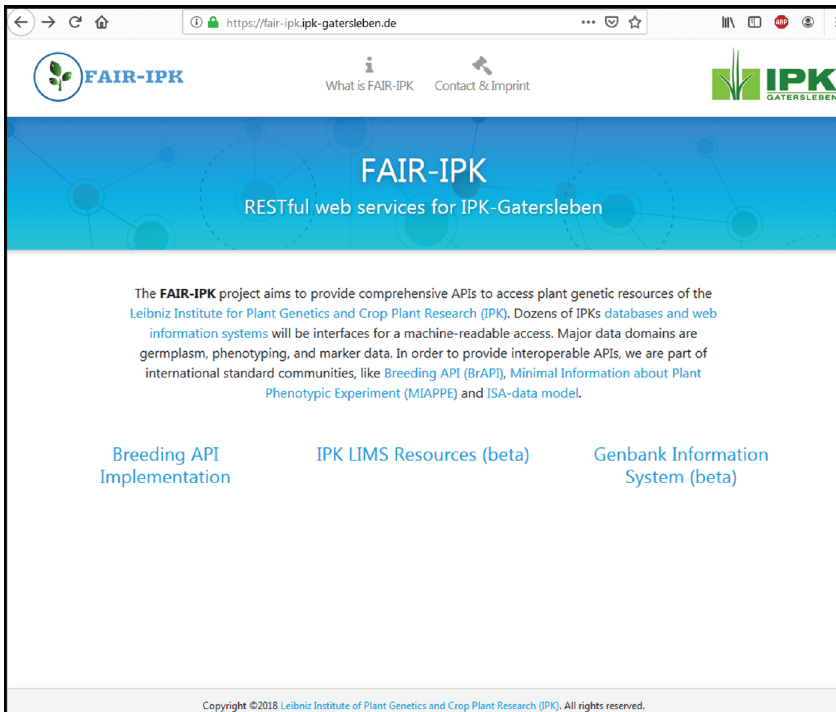
Figure 3: Web interface for accessing digital PGR of